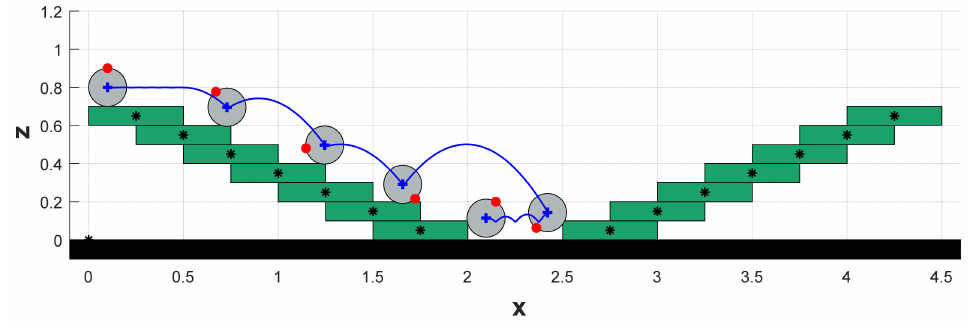
Figure 17. Evolution of the position of the ball rolling on a set of prisms arranged as